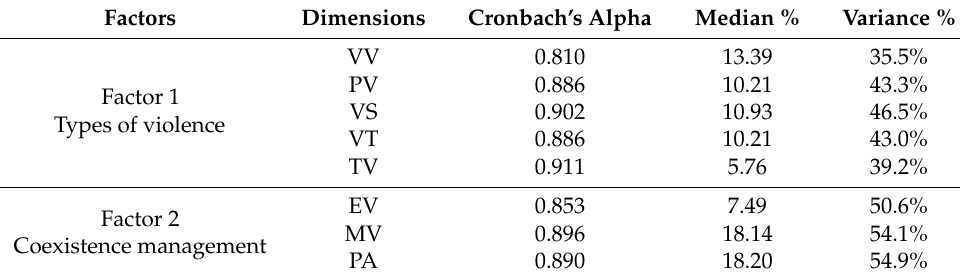
Table 4. Structure of CENVI questionnaire. Source: Muñoz et al.